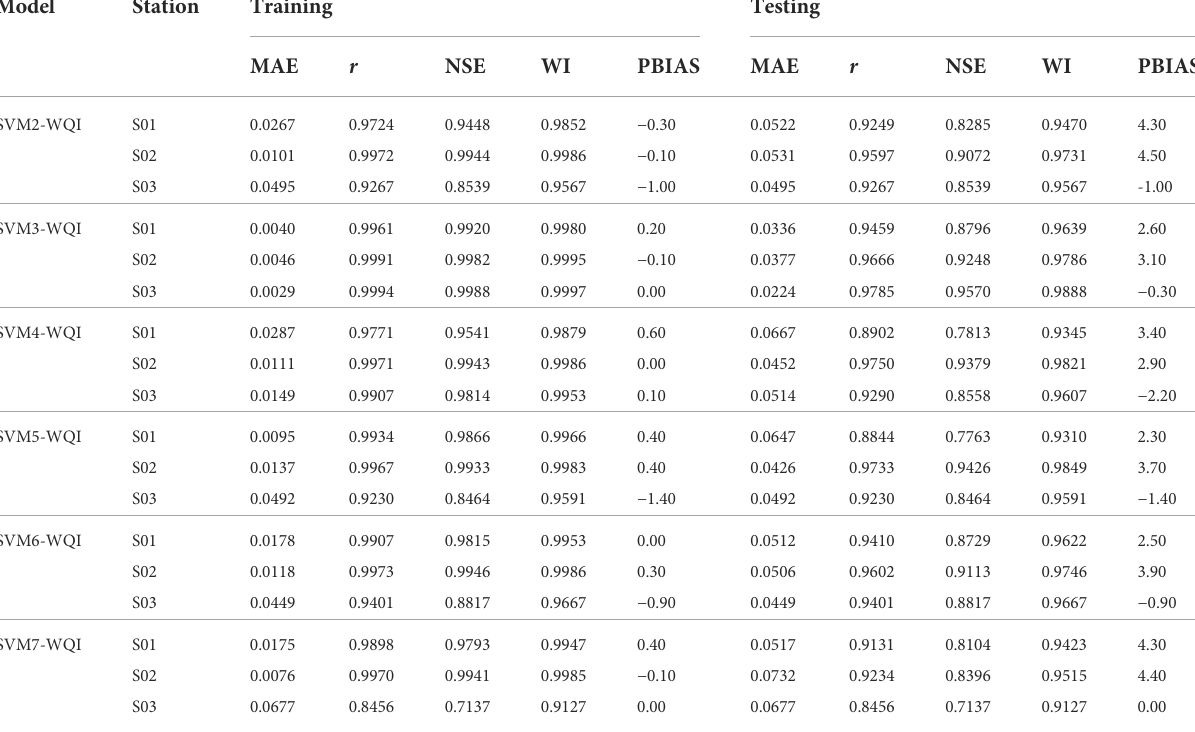
TABLE 8 Performance evaluations for the second scenario.